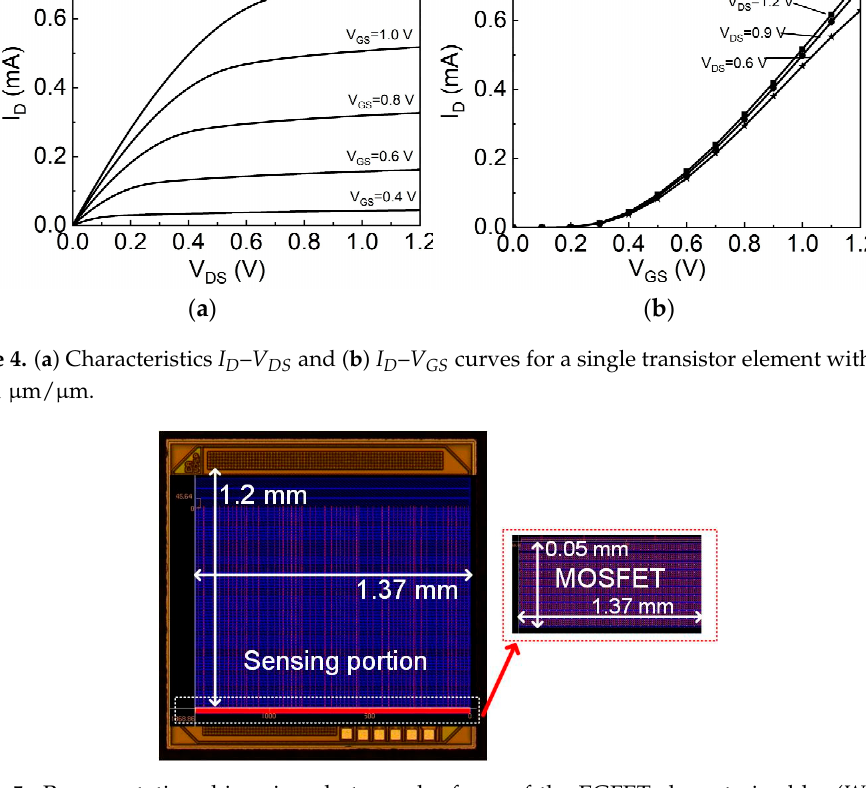
Figure 5. Representative chip microphotograph of one of the EGFET characterized by (W/L) eq = 95 W/L µm/µm. The sensitive layer can be placed within the sensing portion area or externally in a separative EGFET (SEGFET) configuration [26].